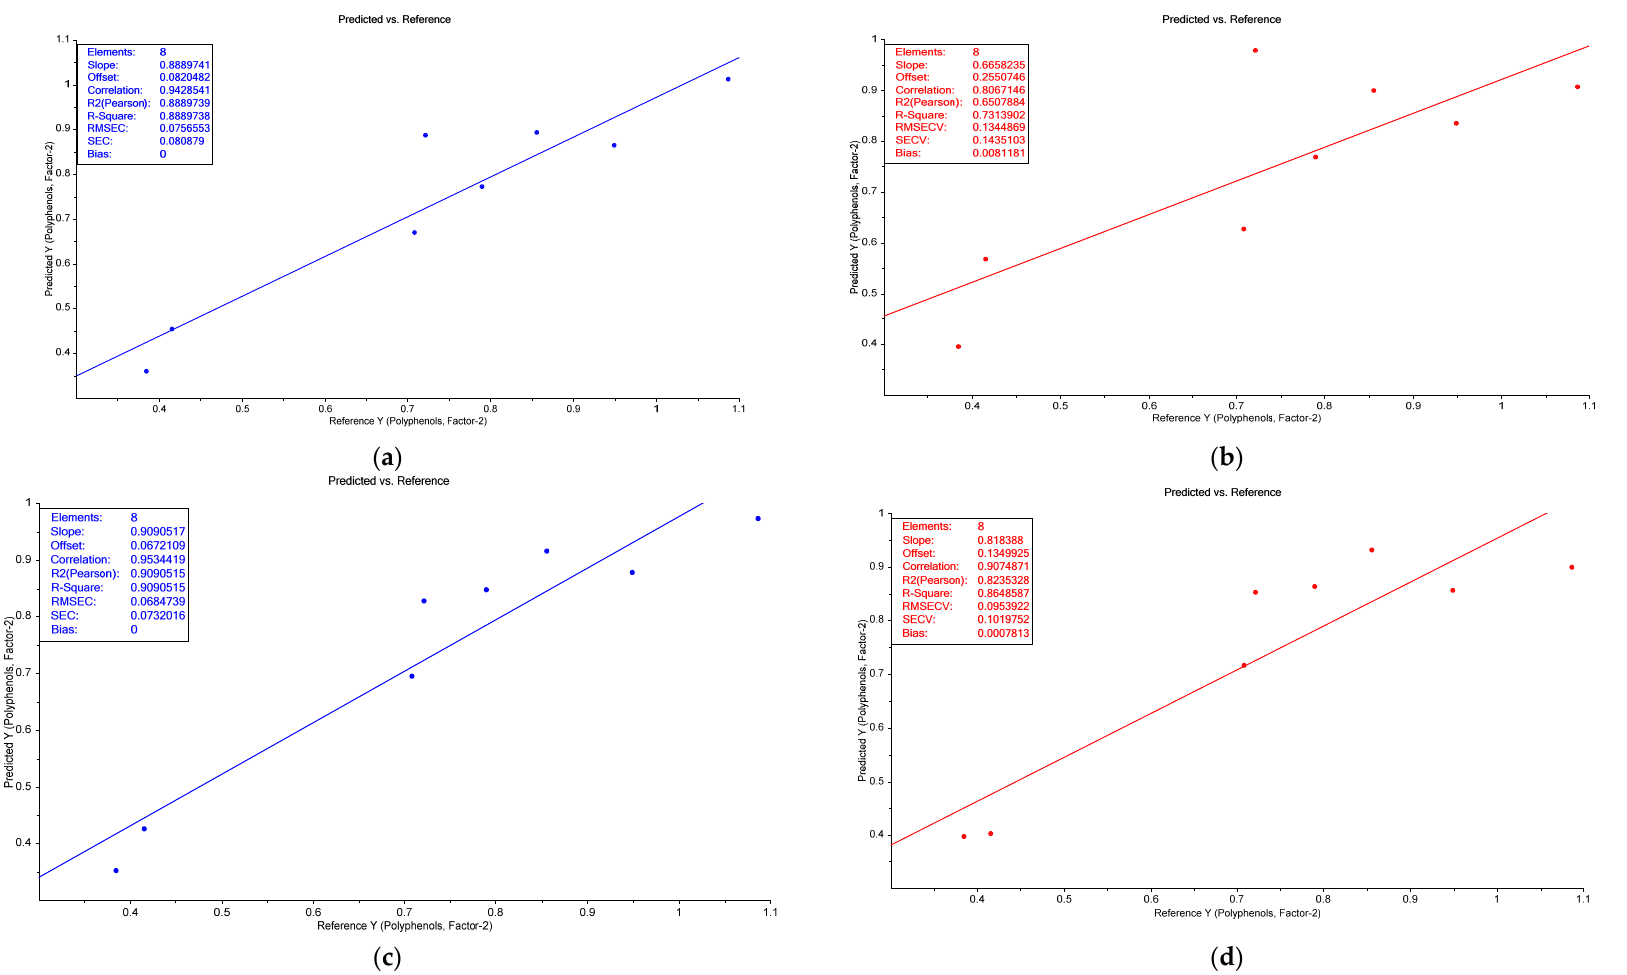
Figure 6. Partial least square (PLS) calibration ( a , c ) and full cross-validation ( b , d ) models for total phenolic prediction by using raw ( a , b ) or pre-treated standard normal variate ( c , d ) FTIR spectra 600–4000 cm − 1 .